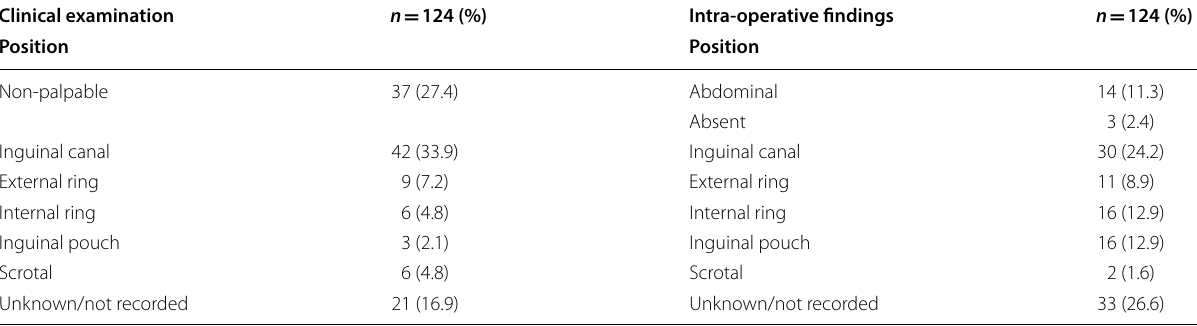
Table 1 Clinical and intra-operative findings Clinical